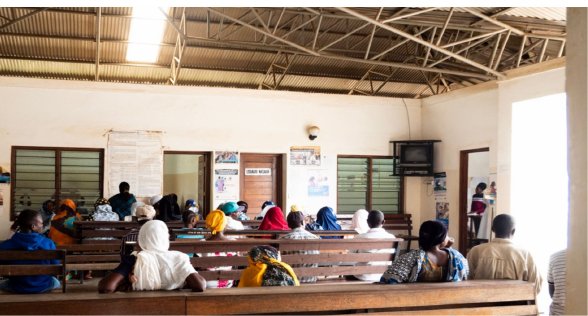
Figure 1. Waiting area of the Chronic Diseases Clinic of